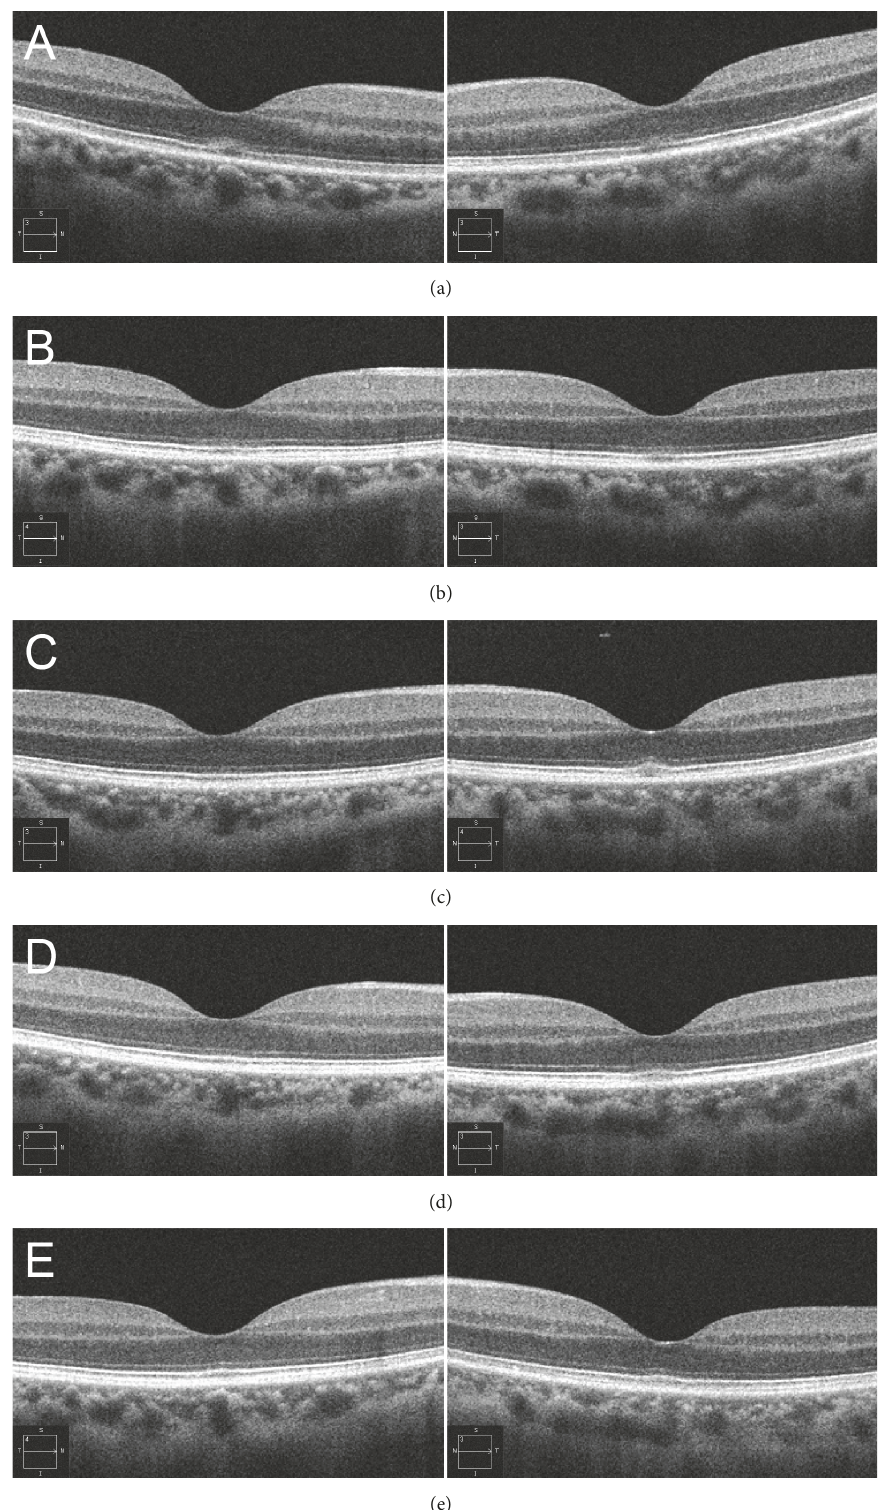
Figure 2: Optical coherence tomography (OCT) images during the follow-up examinations. (a–e) OCT images at 2 (a), 4 (b), 9 (c), 12 (d), and 21 (e) weeks after beginning prednisolone therapy. Ellipsoid zone elevation was improved in both eyes after 2 weeks. Diffused ellipsoid zone gradually improved and became almost normal after 4 weeks in the right eye and after 21 weeks in the left eye. There was observation of the disrupted interdigitation zone after 12 weeks in the right eye and after 21 weeks in the left